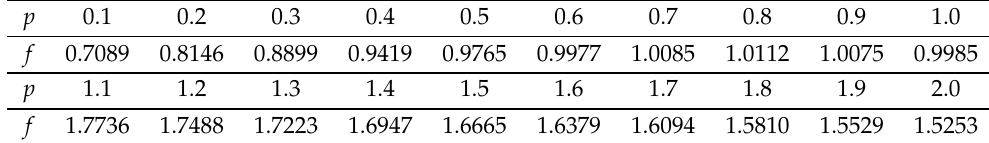
Table 4. Price of the American option with different p (compound Simpson formula).